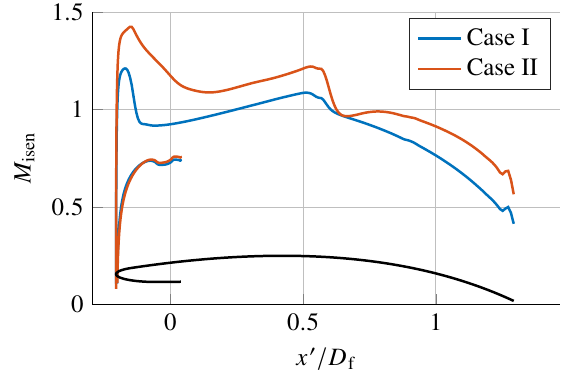
Figure 8. Cowl surface isentropic Mach number M isen .